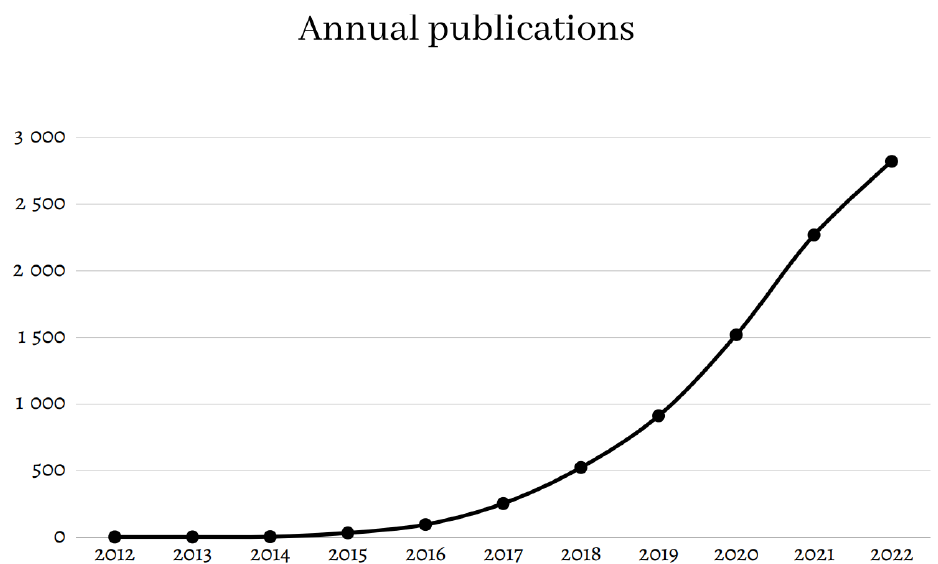
Figure 1. Evolution of the number of annual publications related to radiomics over the past 10 years. Data obtained from PubMed with the keyword “ radiomics ” in February 2023.